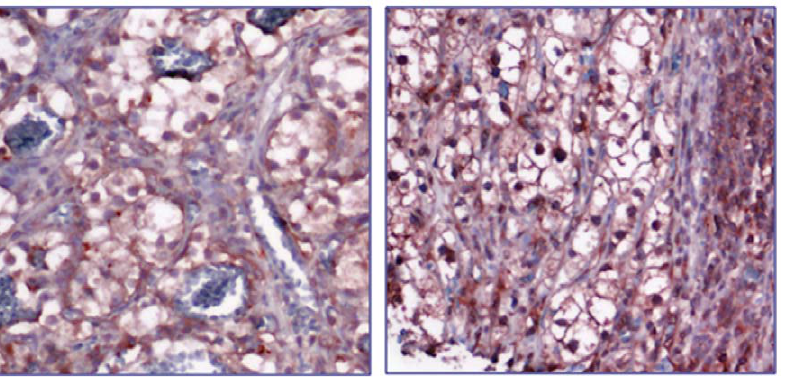
Figure 2. Immunohistochemical staining of total VEGF protein in sections of human RCC tissues. Representative RCC tumor center (left) and margins (right) with lower and strong expression of VEGF respectively.